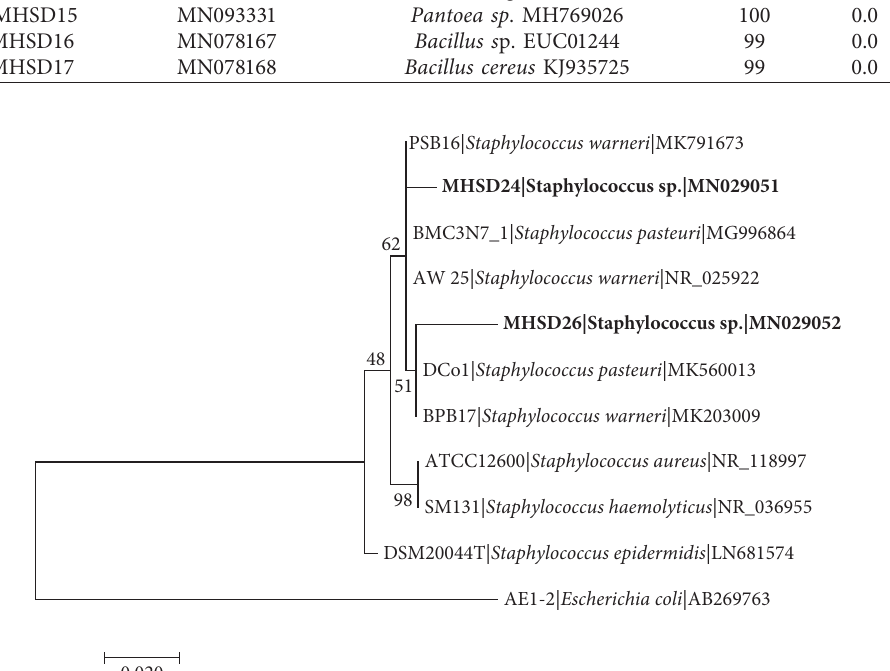
Figure 1: Maximum likelihood phylogenetic tree based on analysis of partial 16S rDNA nucleotide sequences of Staphylococcus sp. strain MHSD24 and MHSD26 with related strains from Staphylococcus genus. Numbers above or below the nodes indicate bootstrap values generated after 1000 replications. Escherichia coli AE-1 (AB269763) was used as an outgroup.